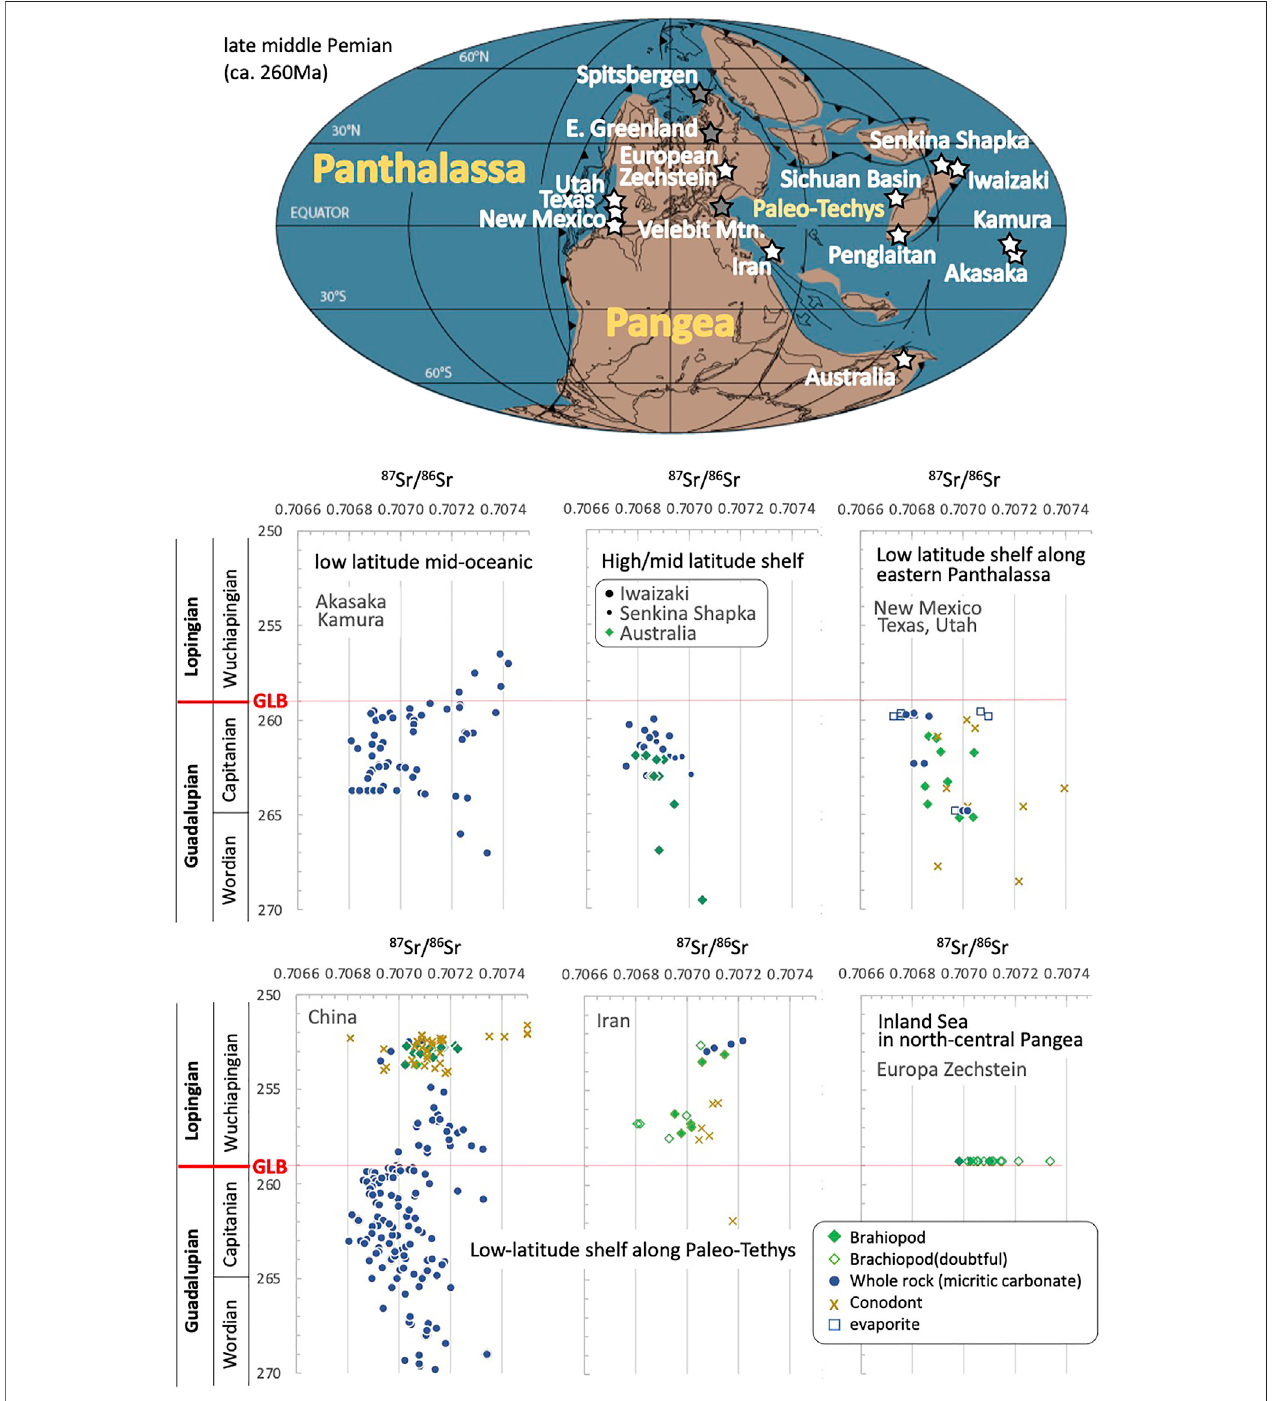
FIGURE 3 | Sr isotope stratigraphy of late middle Permian to early late Permian carbonates at various localities in the world. Middle Permian paleogeographic map of the world modi fi ed from Scotese (2008), Kofukuda et al. (2014), Isozaki et al. (2017). Data sources: Iwaizaki (Kani et al., 2018), Senkina Shapka (Kani et al., 2018), Australia(Morante,1996),Akasaka(Kanietal.,2013),Kamura(Kanietal.,2008),NewMexico(Denisonetal.,1994),Texas(Denisonetal.,1994;MartinandMacdougall, 1995; Korte et al., 2006), Utah (Denison et al., 1994), South China block (Denison et al., 1994; Korte et al., 2003; Korte et al., 2004; Korte et al., 2006; Song et al., 2015; Wang et al., 2018; Li et al., 2020; Li et al., 2021), Iran (Denison et al., 1994; Korte et al., 2003; Korte et al., 2004; Korte et al., 2006; Sedlacek et al., 2014), and European Zechstein (Korte et al., 2006). All data were adjusted to NIST SRM 987 (cid:1) 0.710248 (McArthur et al., 2001) and recalculated according to the Geologic Time Scale 2012 (Gradstein et al., 2012).